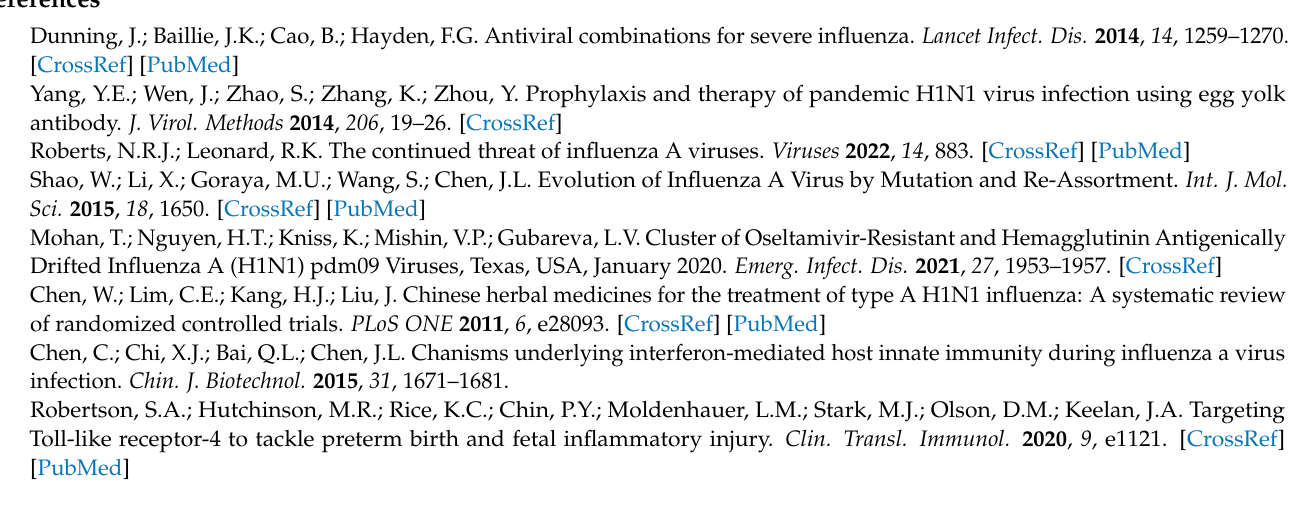
compound 1 ; Figure S2: The 13 C NMR spectrum of compound 1 ; Figure S3: The DEPT spectrum of compound 1 ; Figure S4: The 1 H NMR spectrum of compound 2 ; Figure S5: The 13 C NMR spectrum of compound 2 ; Figure S6: The DEPT spectrum of compound 2 ; Figure S7: The 1 H NMR spectrum of compound 3 ; Figure S8: The 13 C NMR spectrum of compound 3 ; Figure S9: The DEPT spectrum of compound 3 ; Figure S10: The 1 H NMR spectrum of compound 4 ; Figure S11: The 13 C NMR spectrum of compound 4 ; Figure S12: The DEPT spectrum of compound 4 ; Figure S13: The 1 H NMR spectrum of compound 5 ; Figure S14: The 13 C NMR spectrum of compound 5 ; Figure S15: The DEPT spectrum of compound 5